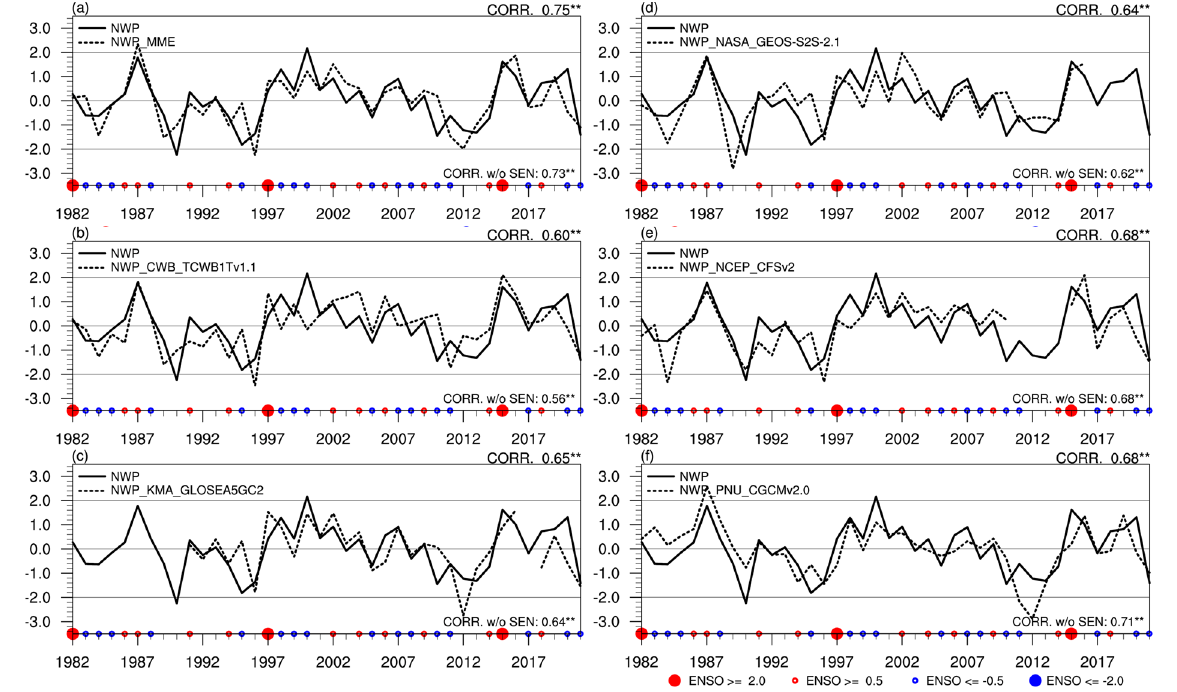
Figure 11. Time series of the NWP index observed (solid line) and predicted (dashed line) by the ( a ) MME and ( b – f ) individual models. The status of the ENSO is shown with the circles on the time-axis. The TCC for the entire series (series without SEN years) is shown in the top (bottom) right corner of the panels. Significant at the 99% (95%) level is denoted with a double (single) as- terisk.